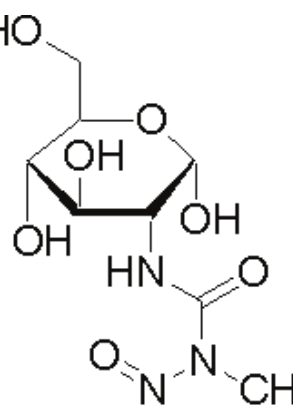
Figure 1: Showing the chemical structure of streptozotocin. STZ has the following systematic chemical IUPAC name: 1-me- thyl-1-nitroso-3-[2,4,5-trihydroxy-6- (hydroxymethyl) oxan-3-